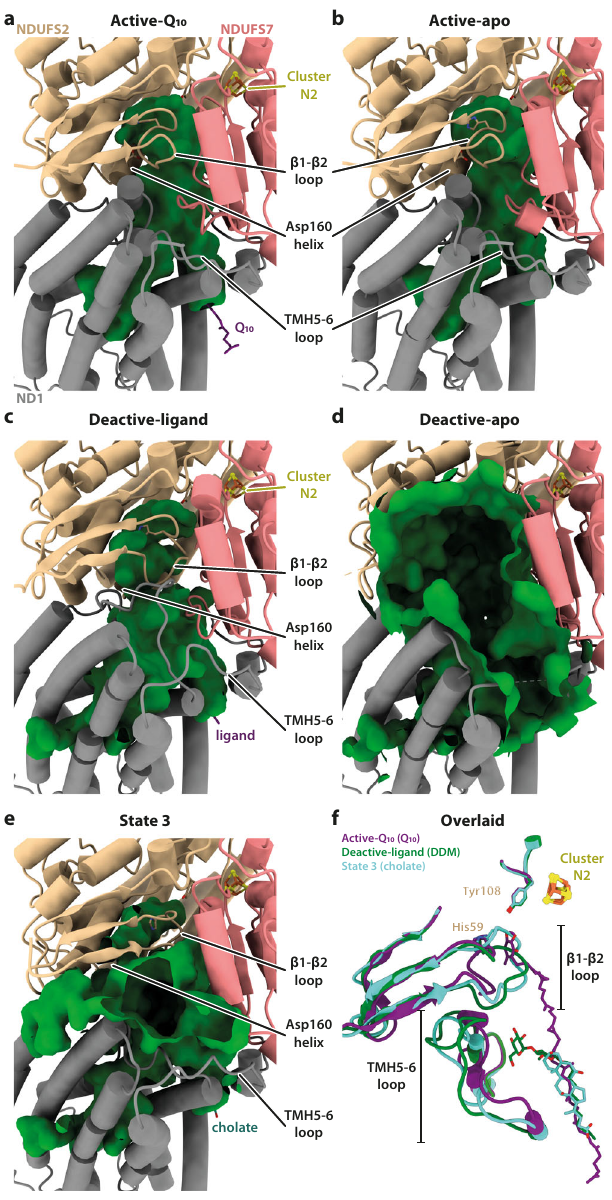
Fig. 4 Conformations of the Q-binding site loops and the cavities they encapsulate in the fi ve observed states of complex I. a – e Cartoon representations of subunits ND1, NDUFS2, and NDUFS7 showing varying extents of disorder indicated as cavities (green surfaces) detected by CASTp 45 . Where visible, His59 NDUFS2 , Tyr108 NDUFS2 and Asp160 NDUFS2 are shown as sticks. f Superimposed structures of the active-Q 10 (purple), deactive-ligand (green) and state 3 (turquoise) states, showing the NDUFS2- β 1- β 2 and ND1-TMH5-6 loops in cartoon, and His59 NDUFS2 and Tyr108 NDUFS2 in sticks.